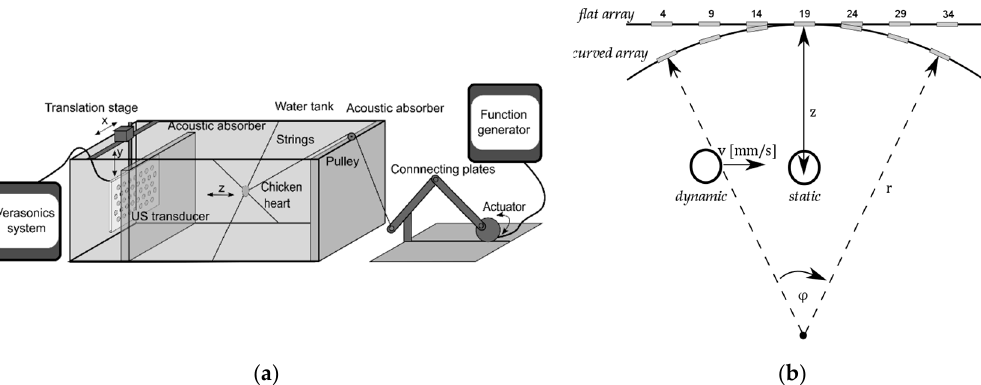
Figure 6. ( a ) Schematic of the fetal heart in-vitro setup. A function generator drives an actuator that is connected via a string to a chicken heart. In this way, the chicken heart is moved along the z -direction in a beat-like fashion. By translating the flexible transducer array through the water tank, a changing fetal heart location can be mimicked. ( b ) Illustration of the transducer array geometry and heart position during experiments.